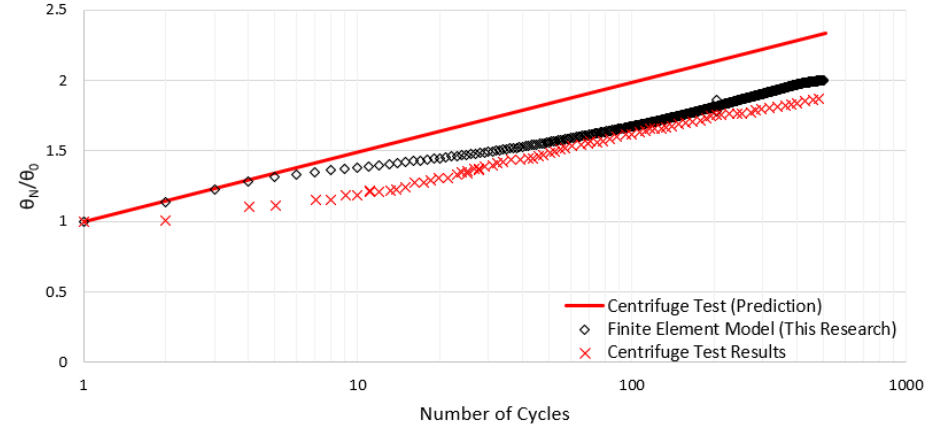
Figure 12. Validation of the cyclic model.